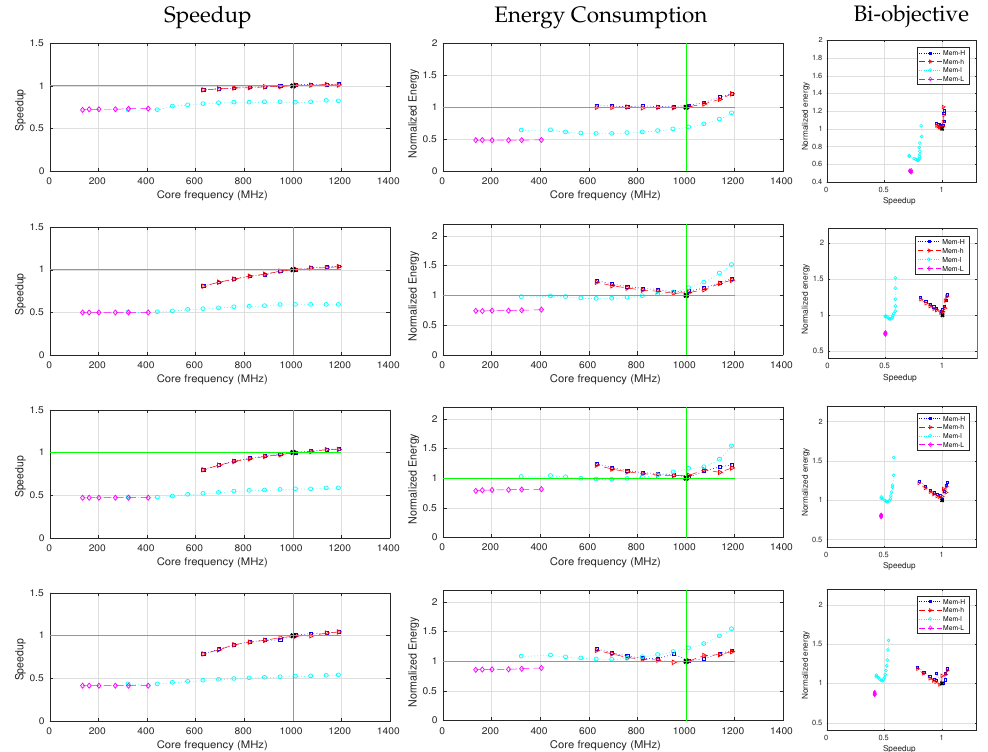
Figure 11. Mersenne Twister results with different memory and core frequency in different input size (8192, 262,144, 524,288 and 1,048,576 from top to